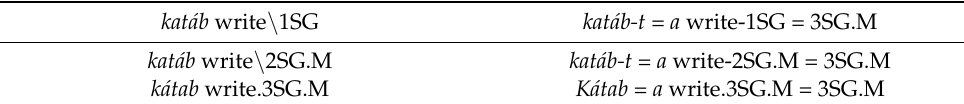
Table 2. Elision of pronominal subjects in the suffixed